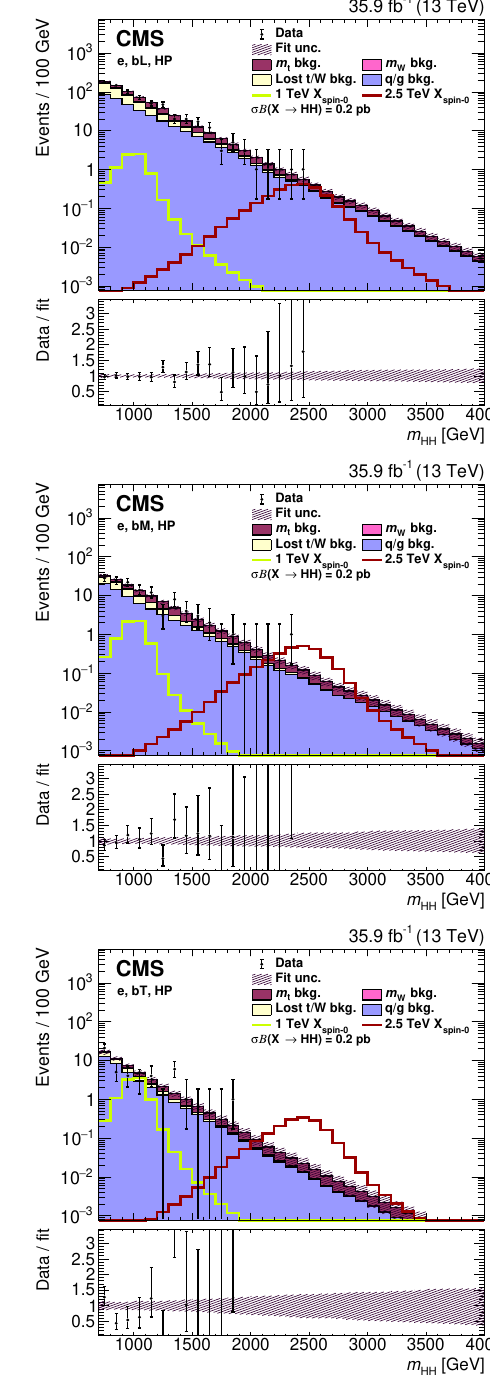
Figure 5 . The (cid:12)t result compared to data projected in m for the electron event categories. The HH (cid:12)t result is the (cid:12)lled histogram, with the di(cid:11)erent colors indicating di(cid:11)erent background categories. The background shape uncertainty is shown as the hatched band. Example spin-0 signal distribu- tions for m of 1 and 2.5 TeV are shown as solid lines, with the product of the cross section and X branching fraction to two Higgs bosons set to 0.2 pb. The lower panels show the ratio of the data to the (cid:12)t